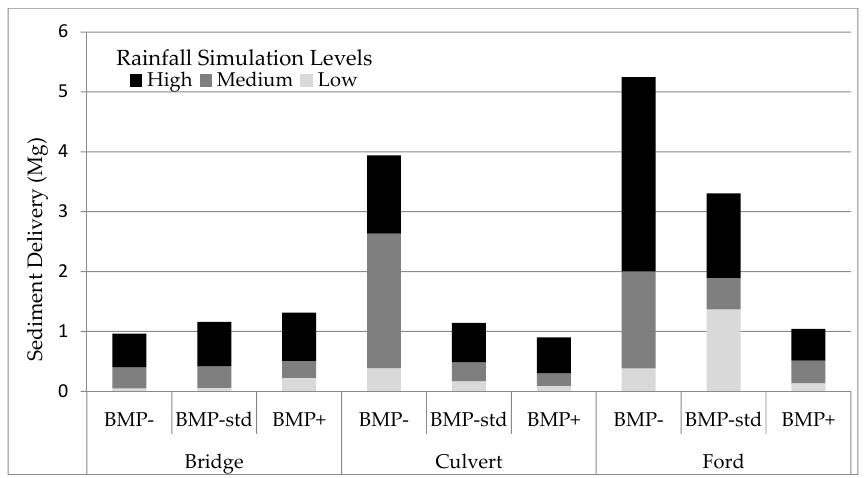
Figure 4. Total sediment delivery (Mg) during the 50-min period beginning with initiation of the 30-min rainfall simulation and for 20 min after completion of rainfall simulation by crossing and BMP